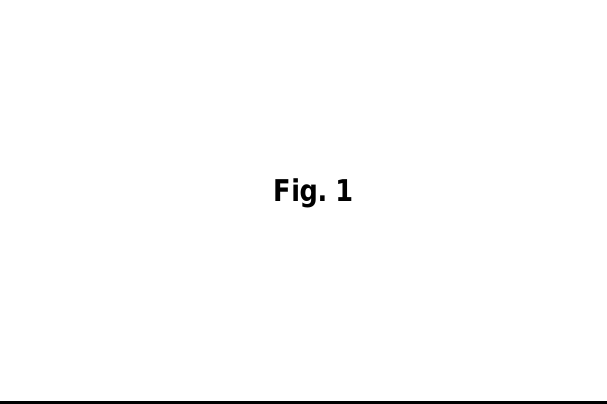
Fig. 1 : Patients positioned and draped for transfrontal stereotactic biopsy. The CRW frame has been mounted over the base